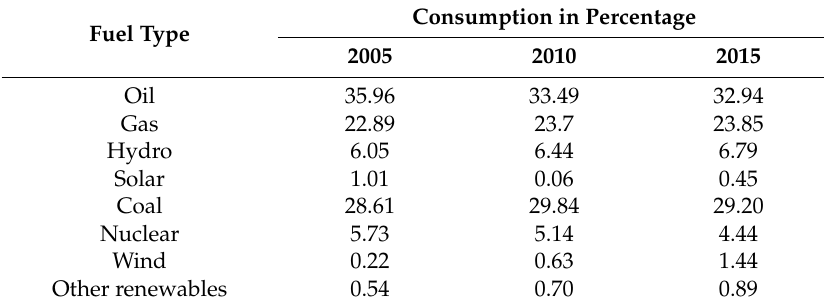
Table 1. Global energy consumption by fuel in 2005, 2010, and 2015 adapted from the World Energy Council (WEC)